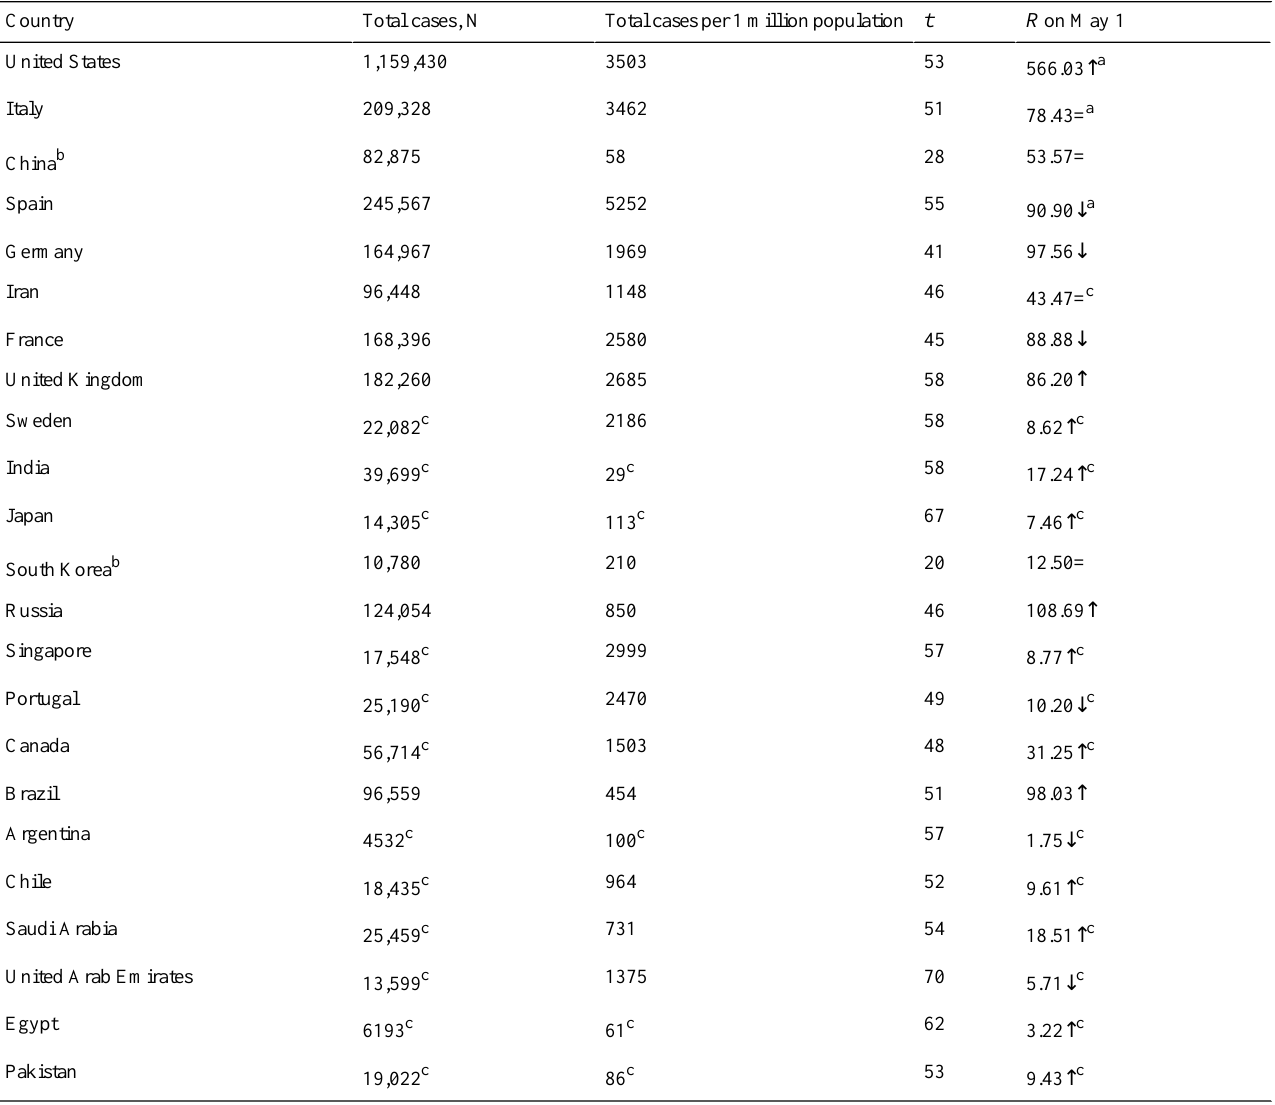
Table 3. Countries with COVID-19 dissemination and total infected cases per 1 million population, as of May 1, 2020. Data source: Worldometer [61].